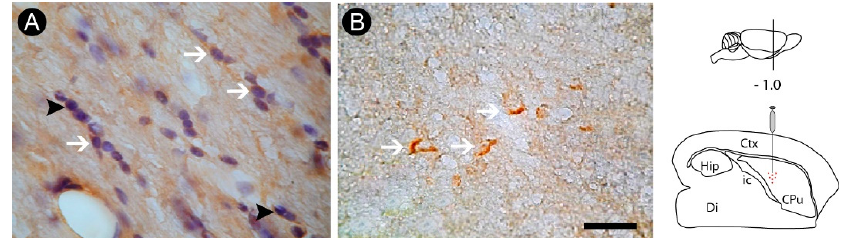
Figure 7. Apoptotic profiles following oligodendrocyte lesion in the internal capsule induced by endothelin − 1 (ET − 1) striatal injection. Nissl counterstaining revealed the presence of pycnotic bodies (arrowheads), a result confirmed by immunohistochemistry for caspase − 3 (arrows) ( B ). Arrows in ( A ) point to Tau + oligodendrocytes. Drawings at the left side of the figure show the anatomical localization of the ET-1 injection in the striatum. Ctx: cortex; CPu: caudate putamen (striatum); Di: diencephalon; Hip: hippocampus; ic: internal capsule. Scale bar: 100 μ m.